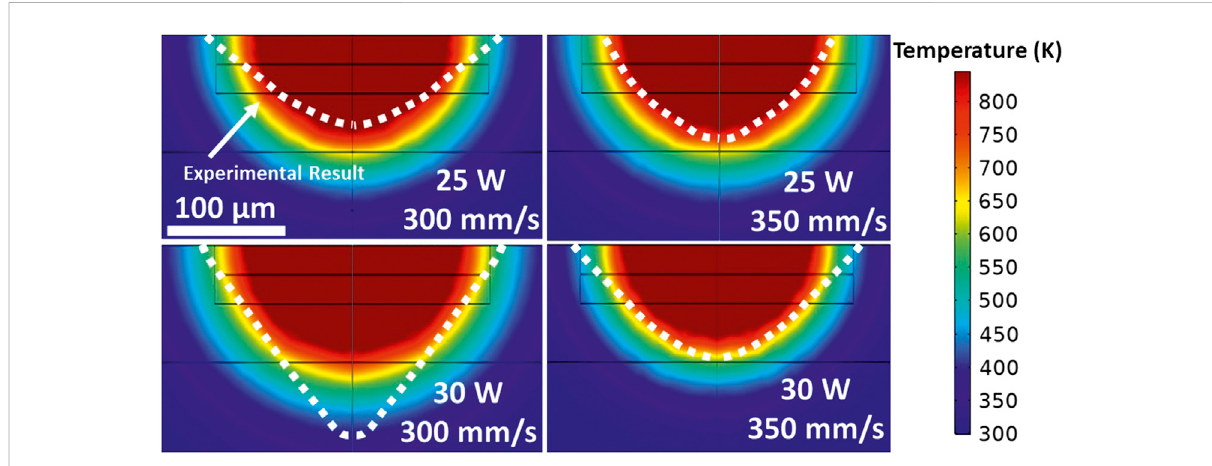
strategy. The dashed white lines show the edge of the melt pool as determined from cross-section images of the experimental samples shown in Figure 6.